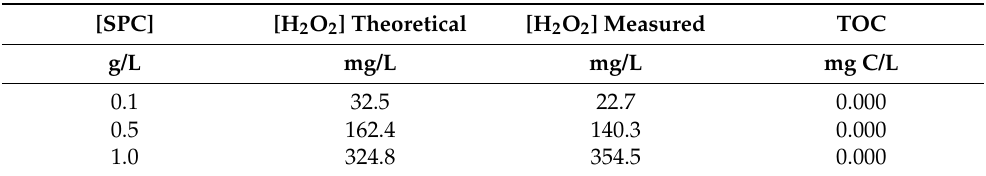
Table 4. Sodium percarbonate release